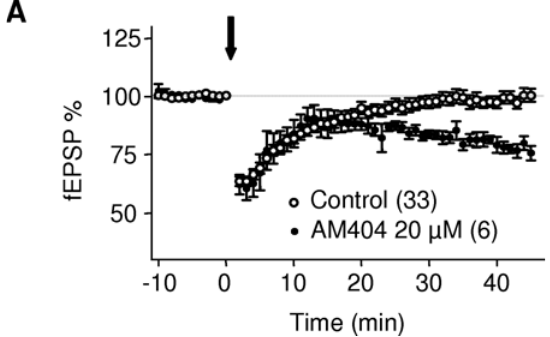
Figure 7. Inhibition of DGL- a , the enzyme that synthesizes 2-AG, blocked eCB-LTD. Averaged time courses of the experiments in which the 10 min at 10 Hz protocol was given in control ACSF (open circles) of after pre-treatment with tetrahydrolipstatin (THL, 10 m M, black circles), an inhibitor of the DGL- a .